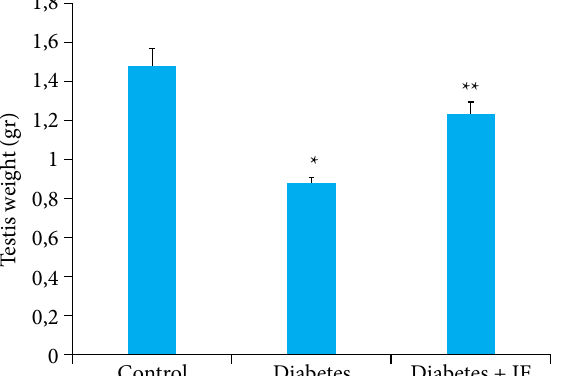
Figure 2 – Testes weights of control, diabetes, and diabetes+IE groups. *p < 0.001 compared to diabetes group; **p < 0.01 compared to diabetes+IE group.